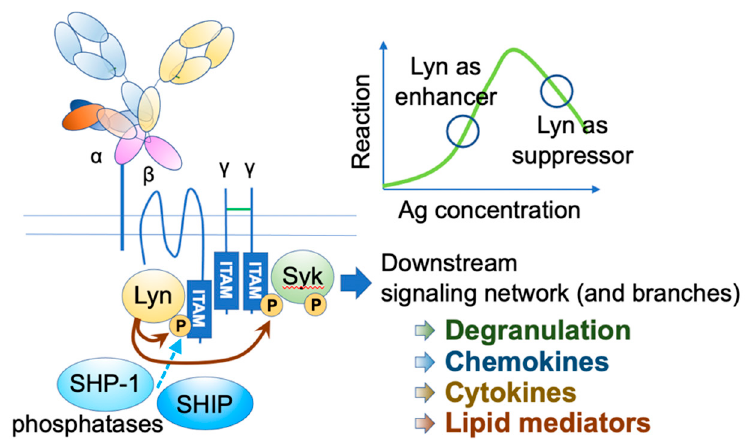
Figure 1. Fc ε RI activation. Upon Fc ε RI aggregation, Lyn initiates downstream signaling events through phosphorylation of ITAMs on Fc ε RI β and γ . Syk binds phosphorylated γ ITAM, and Lyn phosphorylates tyrosine residue of Fc ε RI γ -bound Syk. Activated Lyn and Syk further phosphorylate many downstream signaling molecules, leading to degranulation and de-novo synthesis of chemokines, cytokines, and lipid mediators. Under strong stimuli, Lyn recruits SHIP1 and SHP-1 via the phosphorylated Fc ε RI β ITAM and suppresses the reaction.